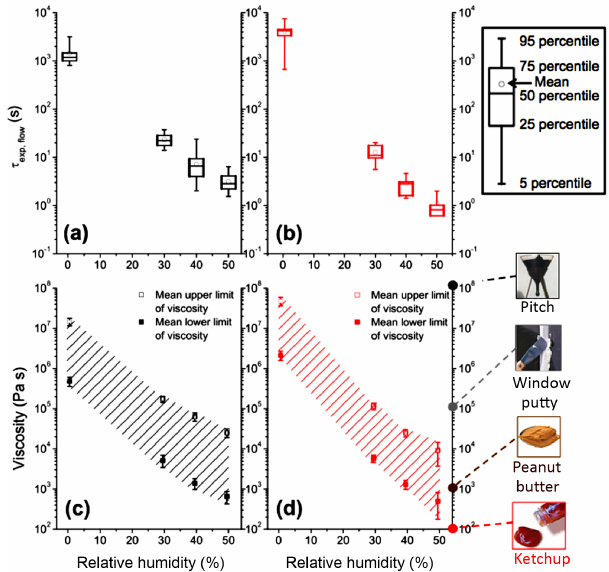
Figure 3. Summary of poke-and-flow experiments from <0.5 to 50% RH performed on samples of the whole SOM produced at mass concentrations of 520µgm − 3 (a, c) and 121µgm − 3 (b, d) . Panels (a) and (b) show box plots of observed τ exp, flow times for particles poked at different RHs. Panels (c) and (d) show the simu- lated lower (filled symbols) and upper (open symbols) limits of vis- cosity. Y error bars represent 95% confidence intervals, and x error bars represent the range of RH at which measurements were made. The shaded regions are included to guide the eye of the reader. The viscosities of common substances at room temperature have been added to (a) to provide points of reference, as per Koop et al. (2011). The image of pitch is part of an image from the pitch drop exper- iment (image courtesy of Wikimedia Commons, GNU Free Docu- mentation License, University of Queensland, John